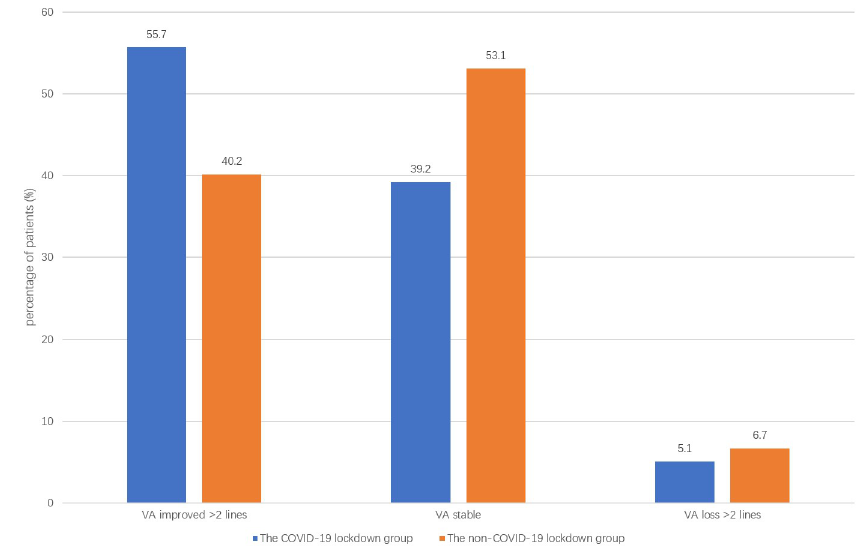
Fig 2. VA changes in the two groups. The percentage of patients with VA gained more than two lines, VA stable, and VA dropped more than two lines was similar between the two groups. There was also no significant difference in the final VA changes between the two groups (p =